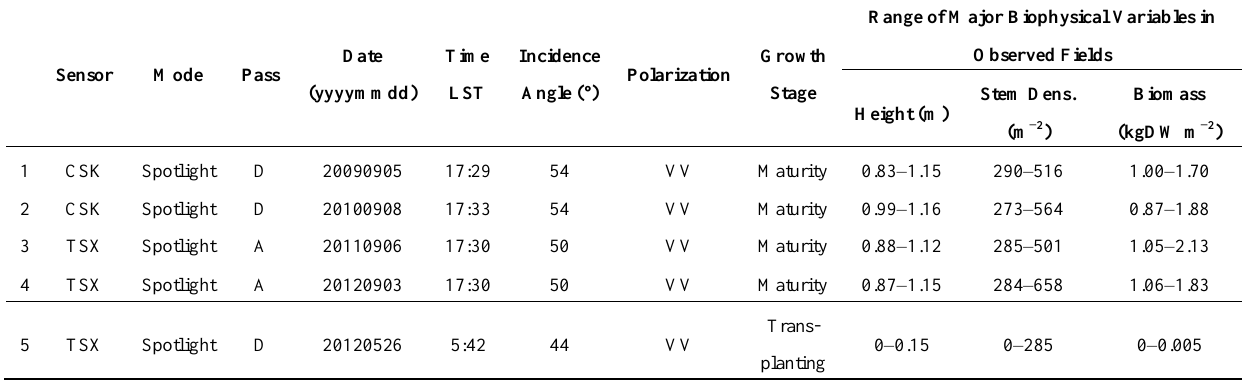
Table 1. Major configurations for SAR observations by the two X-band sensors: CSK and TSX. Range of canopy height, stem density and total dry biomass in plant-sampling fields are indicated for